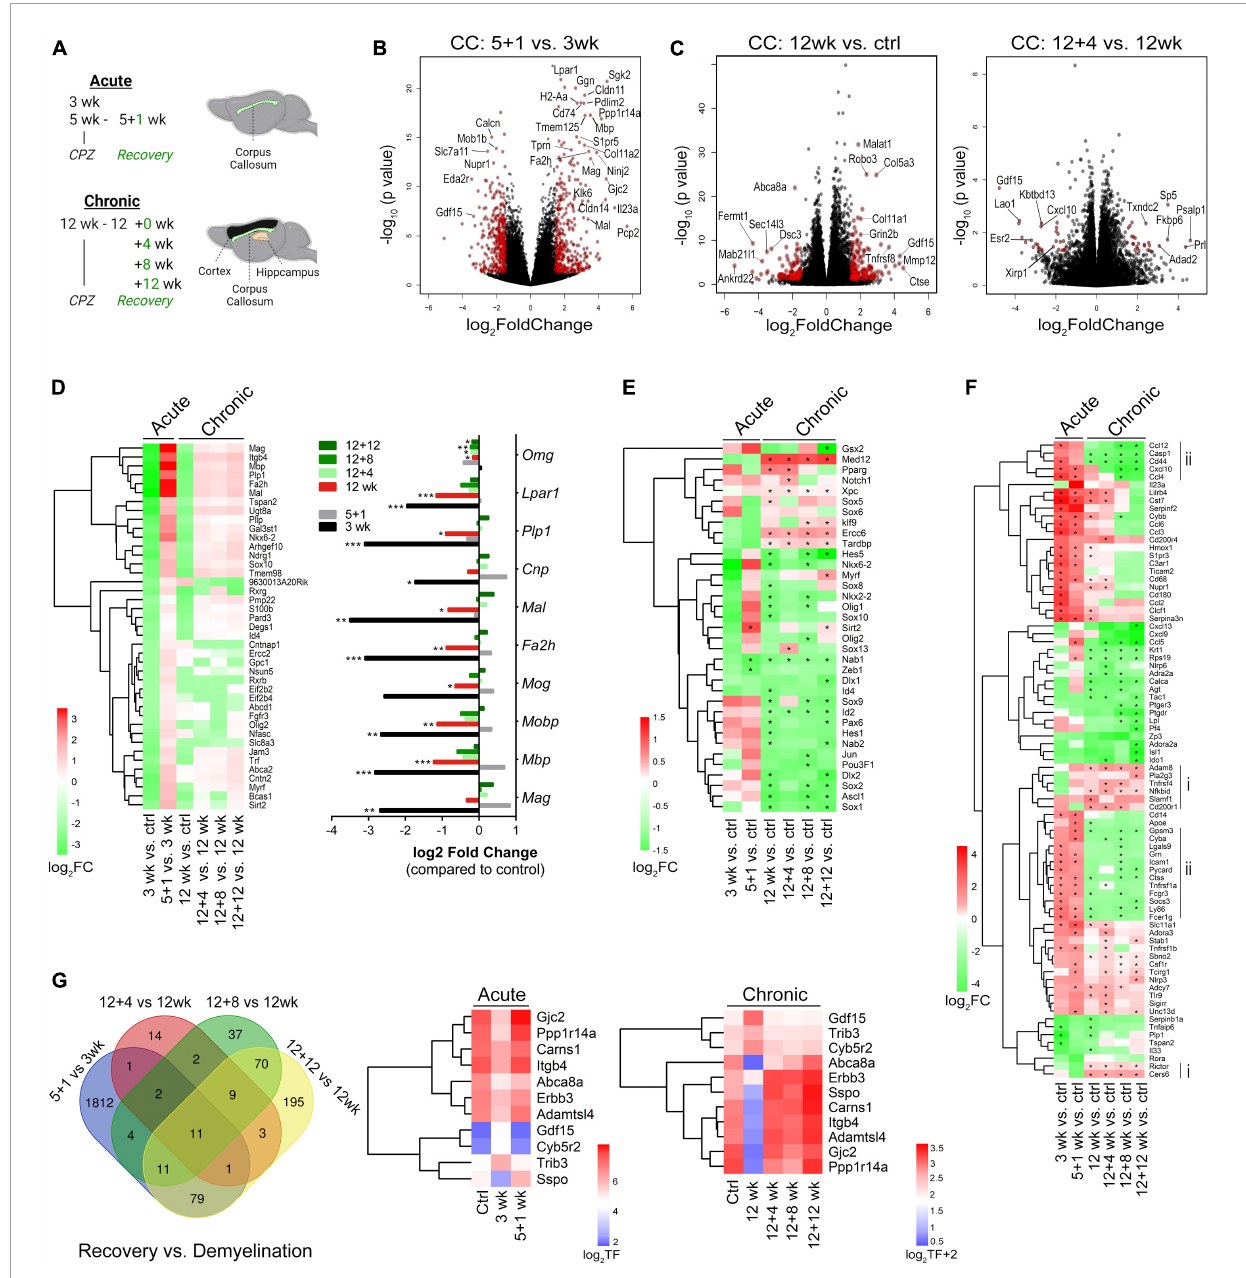
FIGURE3 Transcriptome landscapes of the corpus callosum following acute and chronic demyelination and temporal changes during chronic remyelination. (A) Schematic of experiments outlining timelines for acute and chronic cuprizone treatment and recovery and brain regions used for RNA-seq. (B,C) Volcano plots depicting differential gene expression (DEGs) and p -values between acute remyelination and demyelination samples [5 + 1 vs. 3 weeks, (B) ], and chronic demyelination vs. control samples [12 weeks vs. control, (left C )] and early chronic remyelination vs. demyelination samples [12 + 4 vs. 12 weeks, (right C )]. Colored symbols indicate significantly differentially expressed genes with Log2 FC (fold changes) > 1.5 and p < 0.05. ( D , Left) Heatmap of significant OL-enriched DEGs ( q < 0.05, total 41 genes) at various time points after acute and chronic demyelination. Right, relative fold changes of 10 myelin genes over controls. * q < 0.05, ** q < 0.01, *** q < 0.001. (E) Heatmap of transcription factors/regulators involved in OL lineage cell development and differentiation that were significantly modulated during de/remyelination. Asterisks (*) indicate statistically significant gene changes compared to the controls ( q < 0.05). (F) DEGs that function in the regulation of immune processes and inflammatory responses were analyzed (GO:0006954). Genes were ranked by log2FC and -log10( p -value), with cut-off values of (+6, –6) and FC < 1 across all 6 sample groups. The Heatmap of the top-ranked 81 DEGs shows relative differences (log2 FC) of specific samples vs. controls. Asterisks (*) indicate statistically significant gene changes compared to the controls ( q < 0.05). Vertical lines indicate gene clusters uniquely up- (i) and down-regulated (ii) in chronic de/remyelination samples. (G) Venn diagram showing relative overlapping DEGs ( p < 0.01) among acute and chronic remyelination over demyelination groups. Gene expression levels of the 11 genes common to all comparison groups are visualized as log2 transformed